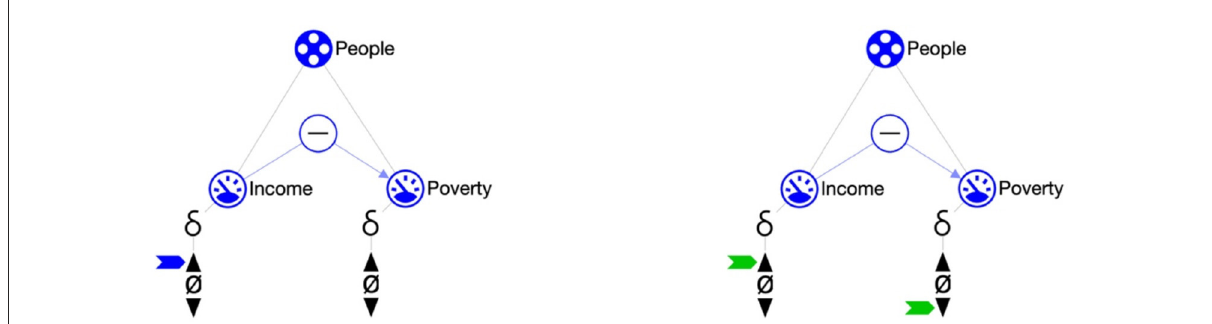
FIGURE5 Fragment of the poverty example (Spitz et al., 2021b). The initial situation (LHS) reads as follows: Entity people has two quantities, Income and Poverty. Income is set to increase and has a negative influence on Poverty. Consequently, when simulated (RHS), poverty decreases as can be inferred from the